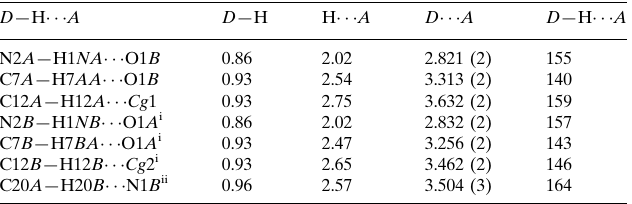
Hydrogen-bond geometry (A˚ , (cid:1)